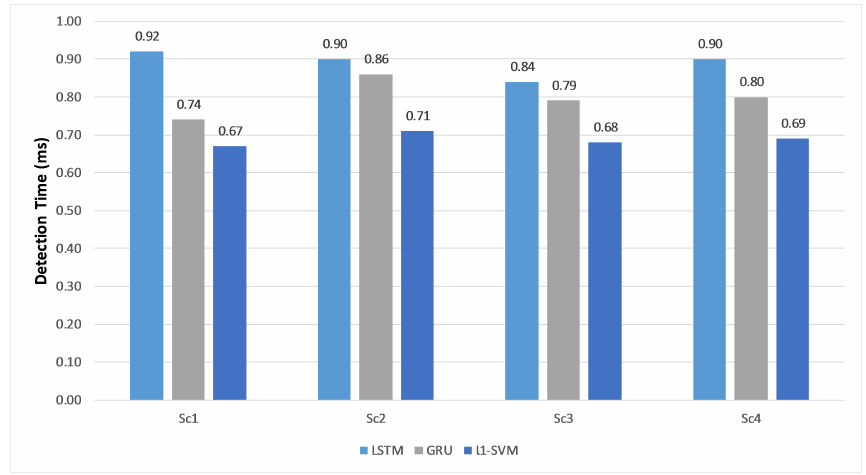
Figure 7. Detection time of the proposed approach on a CPU system (token-based feature